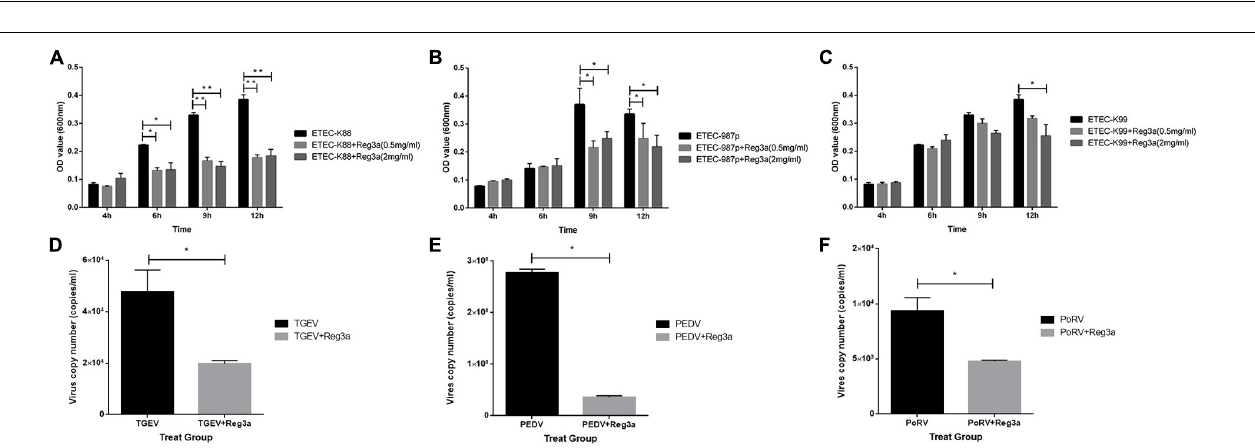
FIGURE 6 | Prokaryotic Expression of the antimicrobial peptide Reg3a Genes. SDS-PAGE analysis for the expression of recombinant proteins in E.coli BL21 with pET-32a vector. The inducing expression of Reg3a was shown in the recombinant vector and not in empty vector (A) . The Western bolt result was as the same as the PAGE (B) .